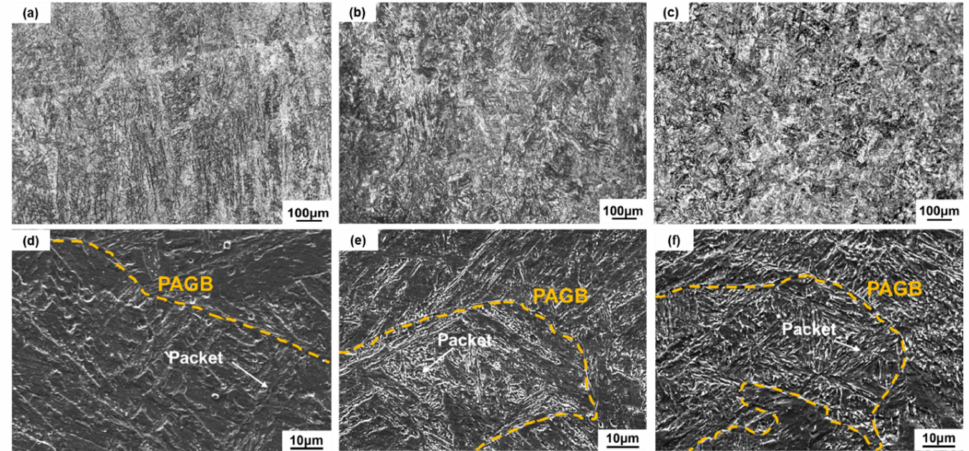
Figure 3. OM micrographs of WAAM samples: ( a ) AP, ( b ) AT and ( c ) SA; SEM micrographs of samples: ( d ) AP, ( e ) AT and ( f ) SA (yellow dotted lines denote prior austenite grain boundary